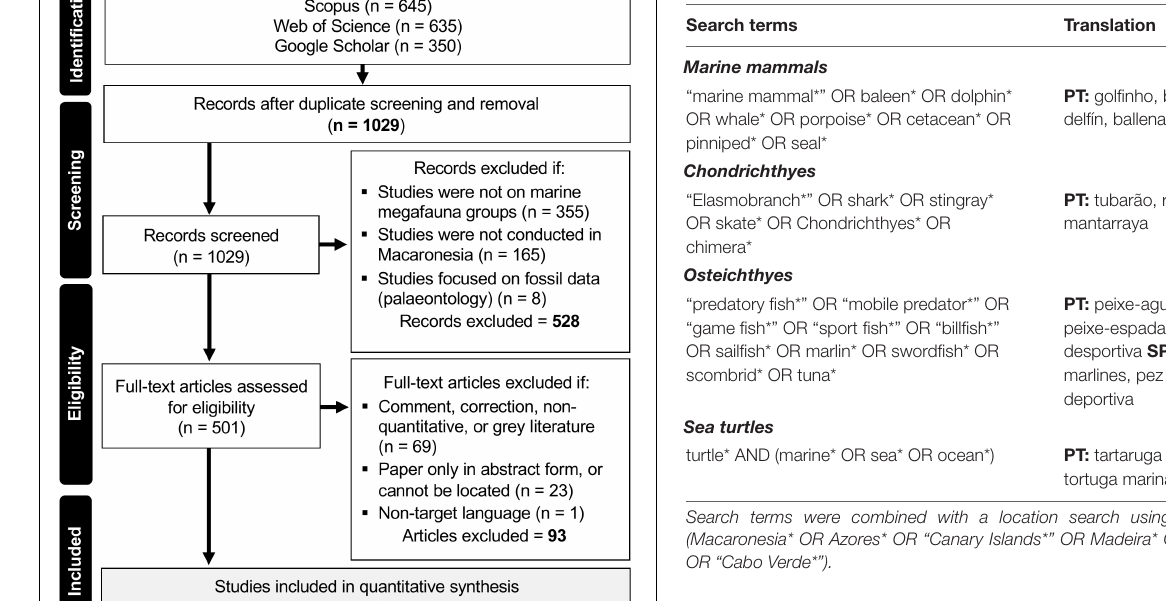
TABLE 1 | Search terms used to locate and acquire relevant literature for the systematic review in English, Portuguese (PT), and Spanish (SP).